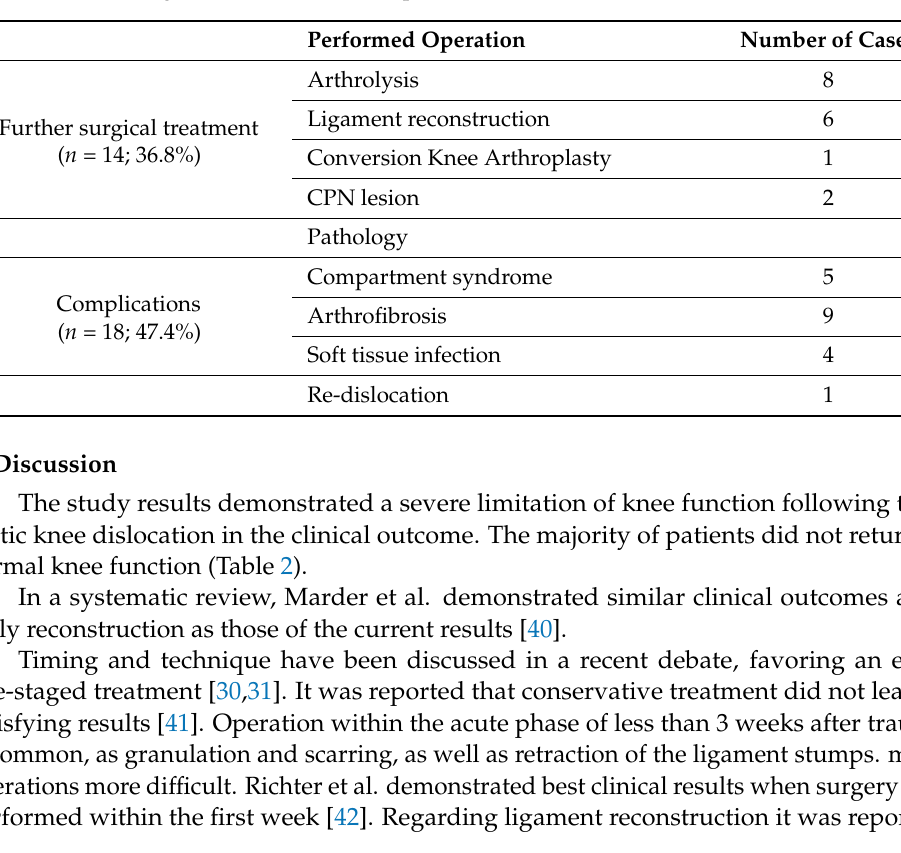
Table 5. Further surgical treatment und complications are demonstrated